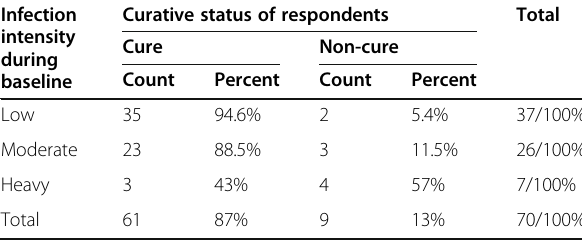
Table 2 The baseline infection intensity and curative status of